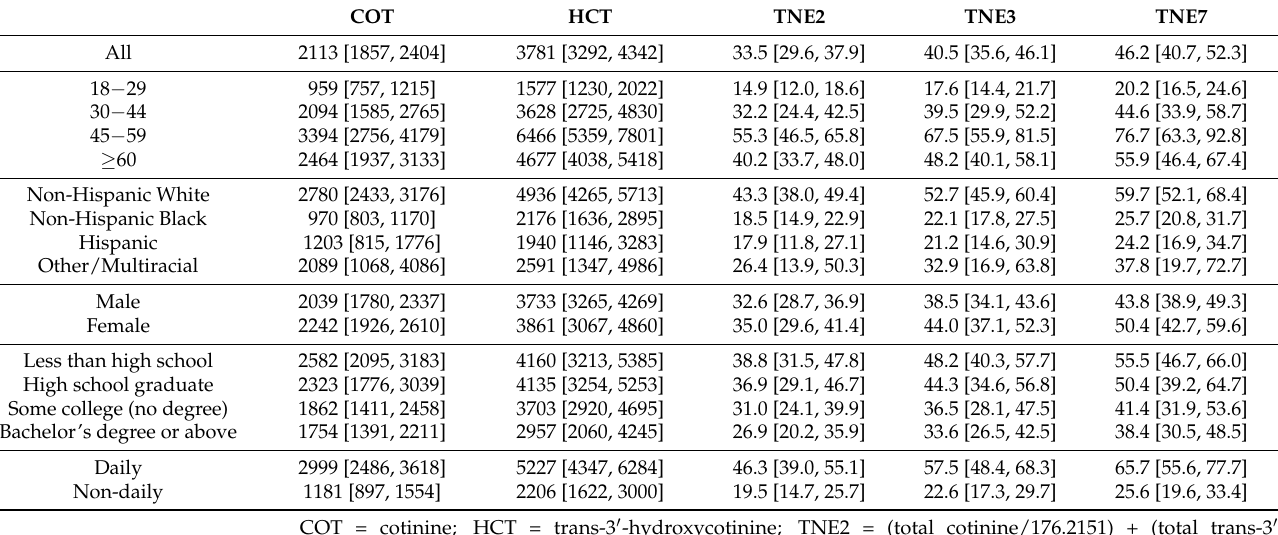
Table 3. Sample-weighted creatinine adjusted geometric mean for cotinine, trans-3 (cid:48) -hydroxycotinine ( µ g/g creatinine) and TNE2, TNE3, TNE7 ( µ mol/g creatinine), with 95% confidence interval, among people who use tobacco, from NHANES